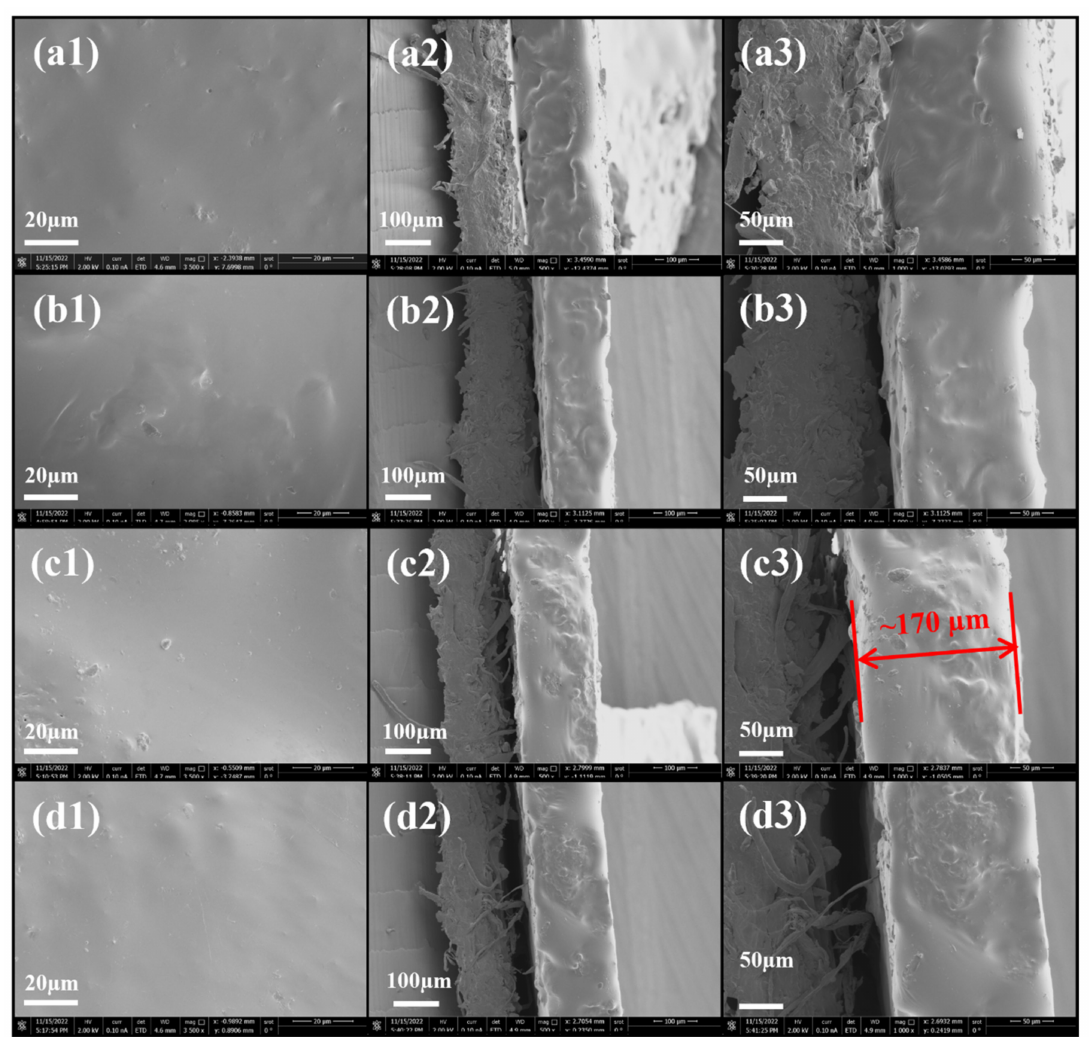
Figure 6. Surface and cross-section SEM images of the prepared CSEs containing ( a1 – a3 ) PEO/LiTFSI, ( b1 – b3 ) 2 wt% PLiSSPSI- g -SiO 2 , ( c1 – c3 ) 6 wt% PLiSSPSI- g -SiO 2 , and ( d1 – d3 ) 10 wt% PLiSSPSI- g - SiO 2